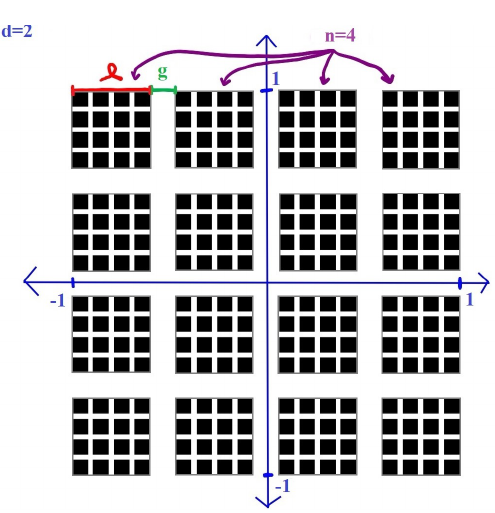
Figure 11. A corner Cantor